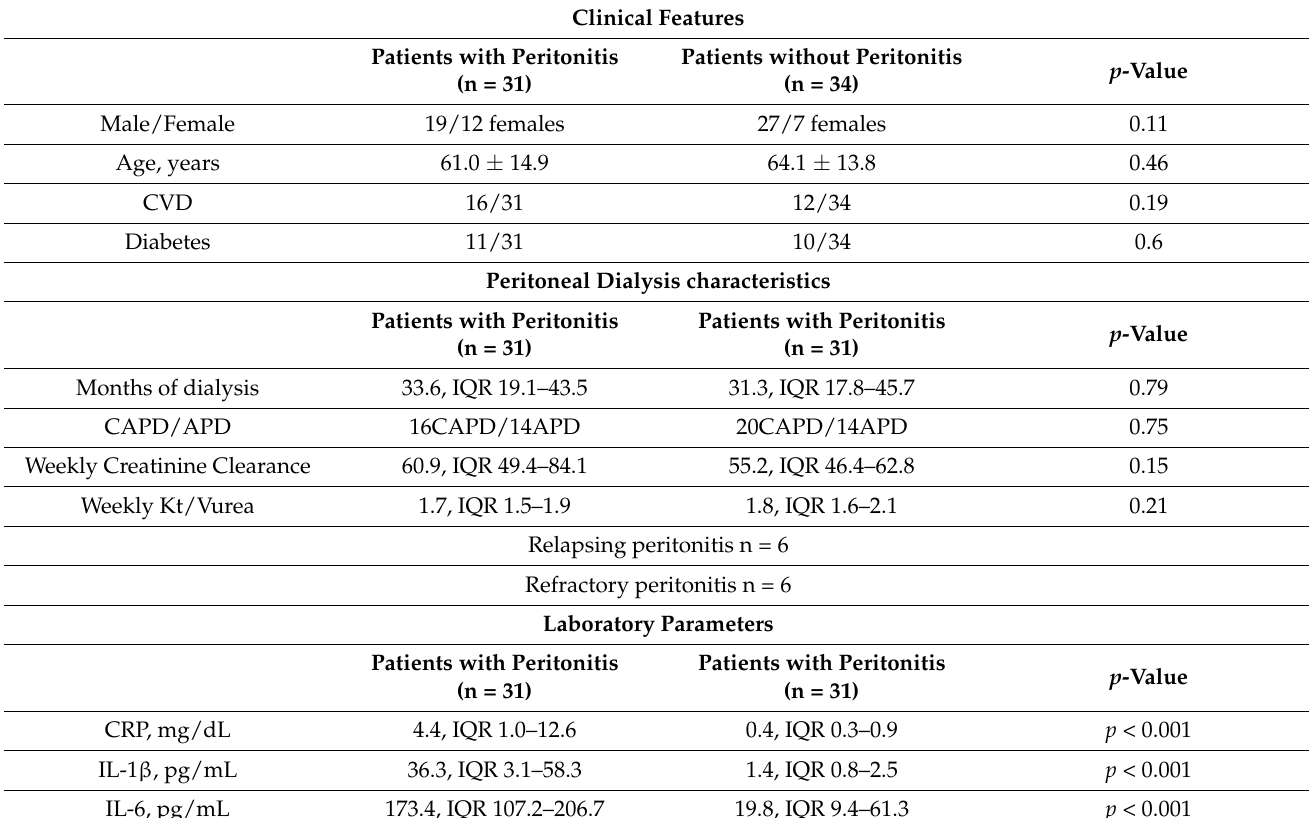
Table 2. Clinical PD-related parameters and conventional and unconventional inflammatory markers in patients with and without